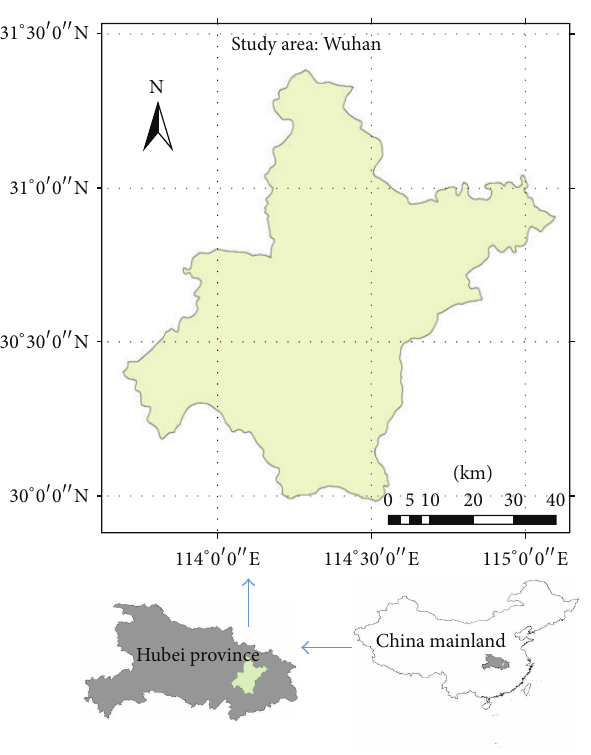
Figure 1: Wuhan city, the research area.